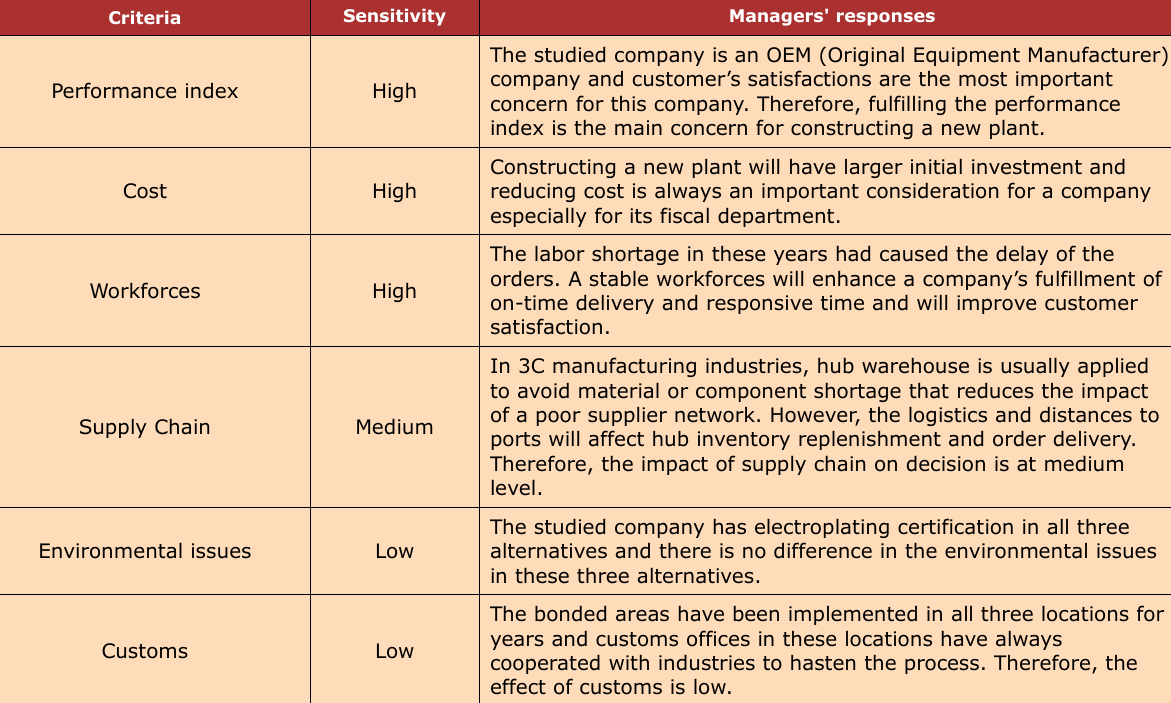
Table 13. Sensitivities of the